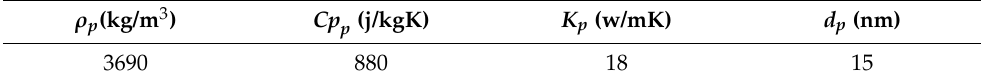
Table 2. Thermophysical properties of a